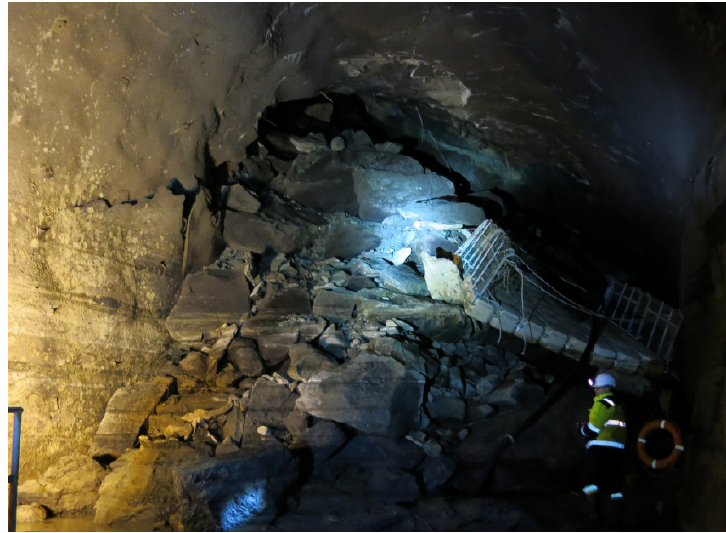
Figure 3. The collapse 1 after water pumping